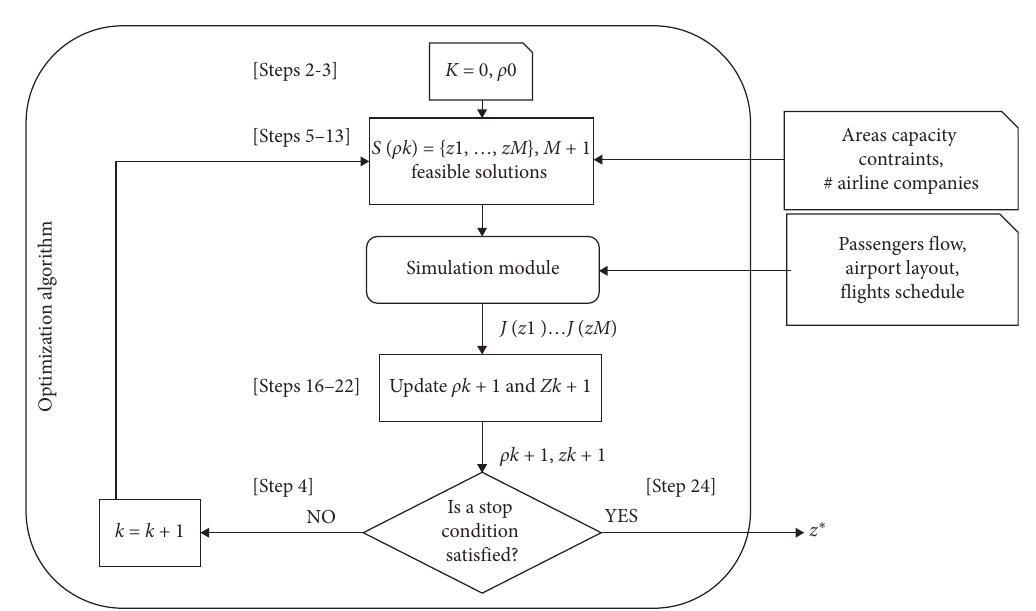
Figure 5: General scheme of the proposed